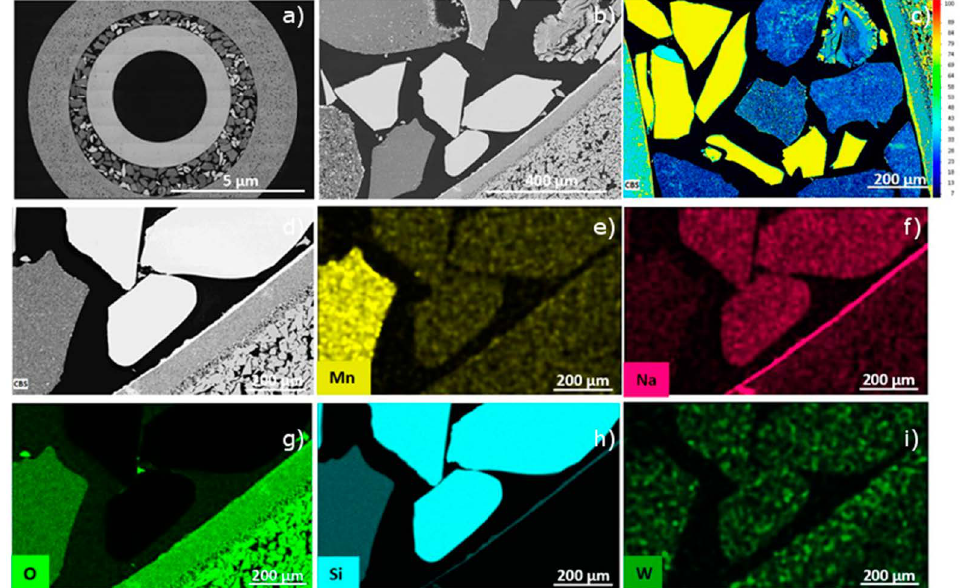
Figure 8. SEM images combined with a concentric backscattered (CBS) images ( a – d ) and EDS images ( e – i ) showing the morphology and microstructure of Mn–Na–W/SiO 2 pelletized powder in alumina MFB reactor. Note the formation of a sublayer of Na and silica (possibly in the form of Na silicate) on the inner wall of the alumina tube after reaction (legend: Mn—yellow, Na—fuchsia, O—light green, Si—cyan, W—dark